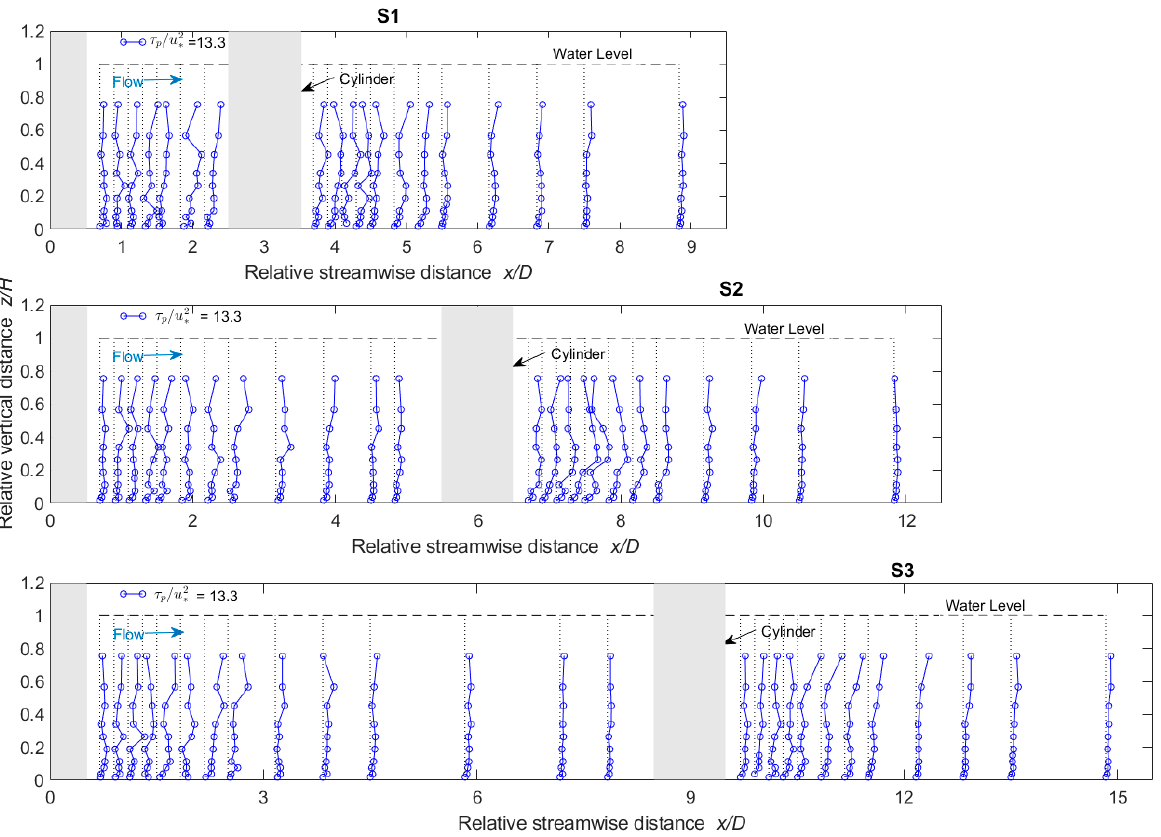
Figure 7. Vertical profiles of dimensionless resultant Reynolds shear stress ( τ p /u * 2 ) in the symmetry plane for the 3 experimental scenarios S1, S2, and S3, combining both midstream and downstream.